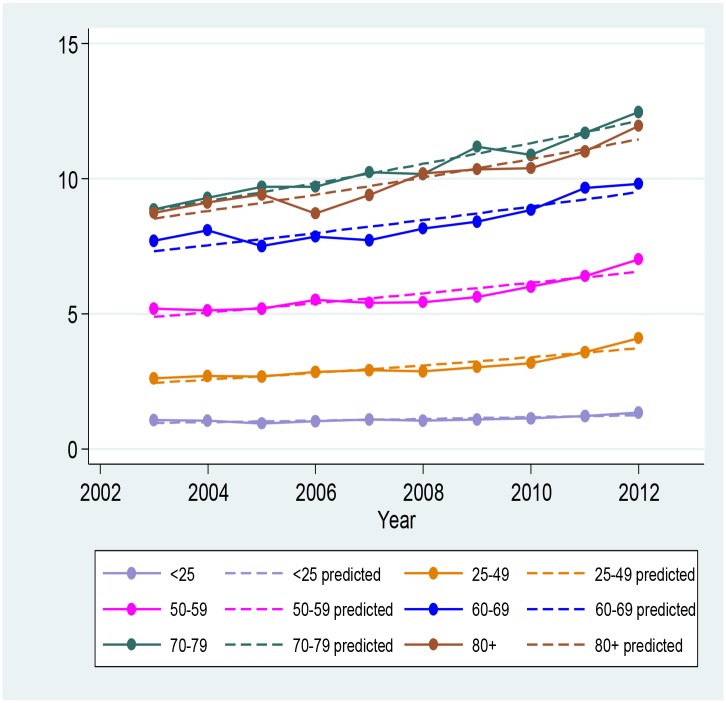
Trend in antiviral prescription rates over time in the Australian population.